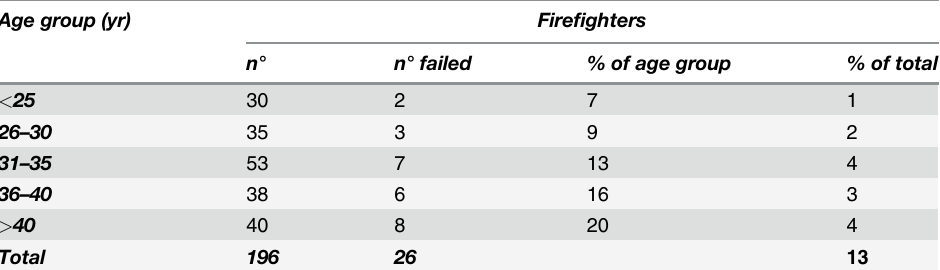
Table 2. Fire fi ghters (n°), number (n° failed) and percentage (%) of Fire fi ghters who did not complete the Queen ’ s College step test with PC+